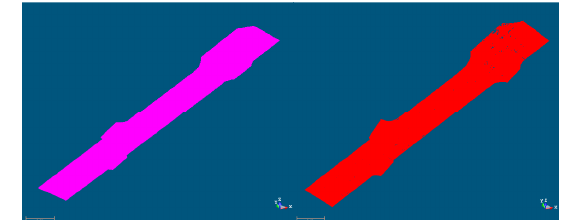
Figure 17. The street floor of Auriga Dr. Left: truth data. Right: the extracted street floor.